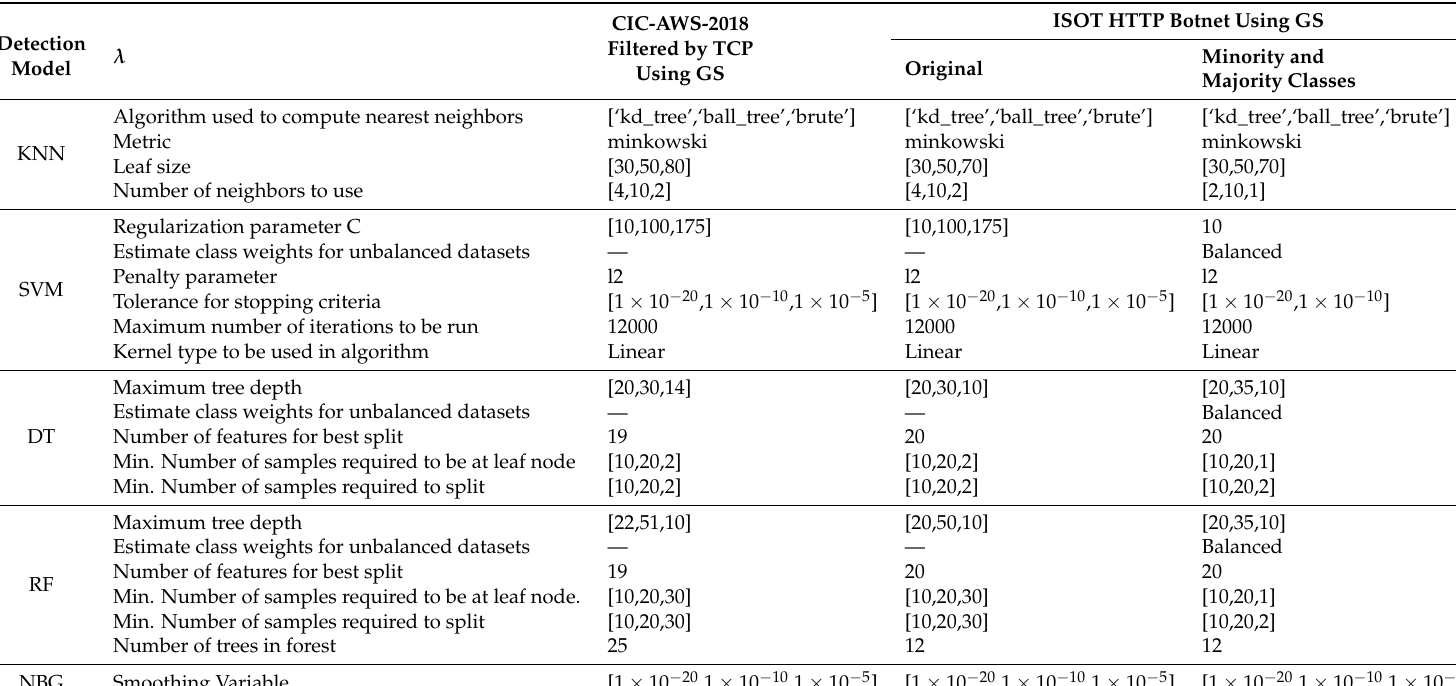
Table A2. Algorithms with Their Inherent Hyperparameters and